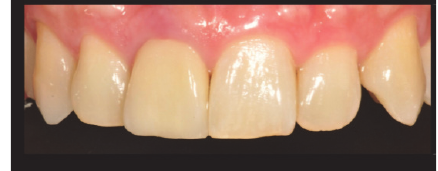
Figure 6: Follow-up of 5